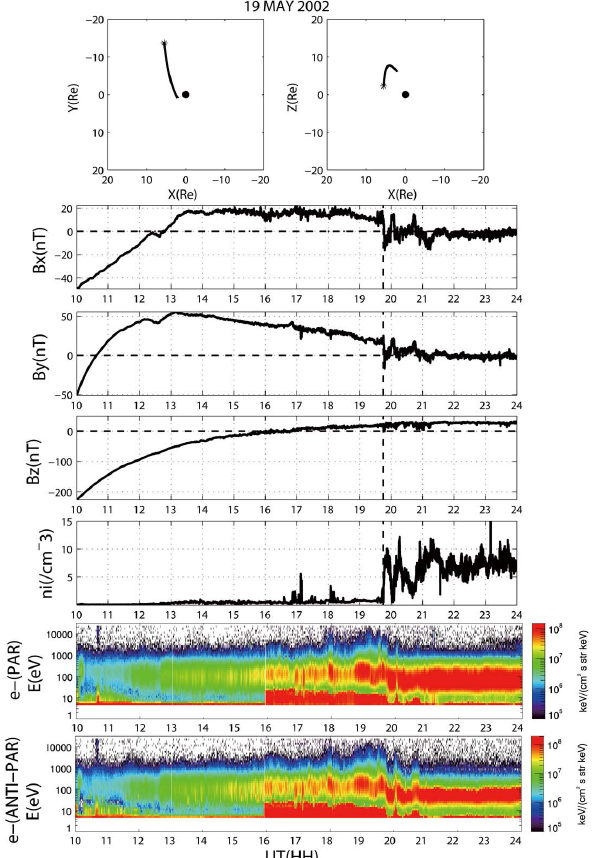
Figure 2. The temporal variation in the plasma and magnetic field observations by Cluster 3 (C3) during the RIMF period on 19 May 2002. From top to bottom, the figure shows the magnetic field com- ponents B x , B y , B z in the GSM coordinate system, the ion number density ( n i ), and electron fluxes parallel and antiparallel to the mag- netic field from 10:00UT to 24:00UT. The orbital track of C3 in the GSM coordinate system is also shown in the top